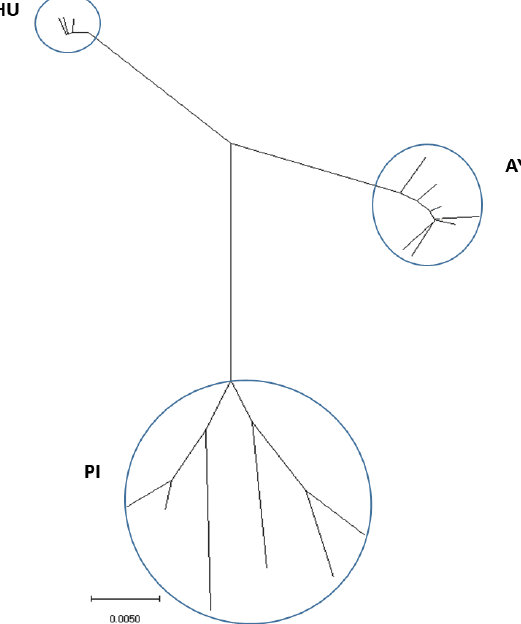
Figure 2. Phylogenetic tree of cytochrome oxidase I sequences among Lutzomyia ayacuchensis pop- ulations. The scale bar represents 0.005% divergence. AL, Alausi; HU, Huigra; PI, Piura; AY, Aya- cucho.